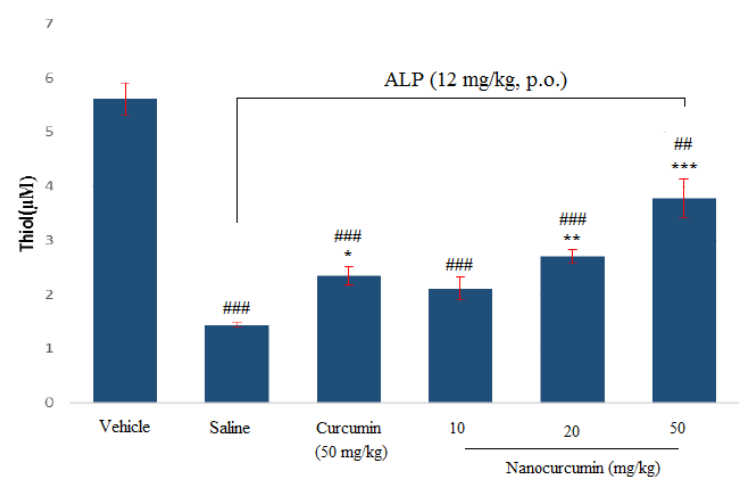
Fig. 4. Effects of curcumin and nanocurcumin on thiol levels in ALP-intoxicated rats. ## P<0.01 and ### P<0.001 significantly different from vehicle. * P<0.05, ** P<0.01 and *** P<0.001 significantly different from control group (ALP + saline).